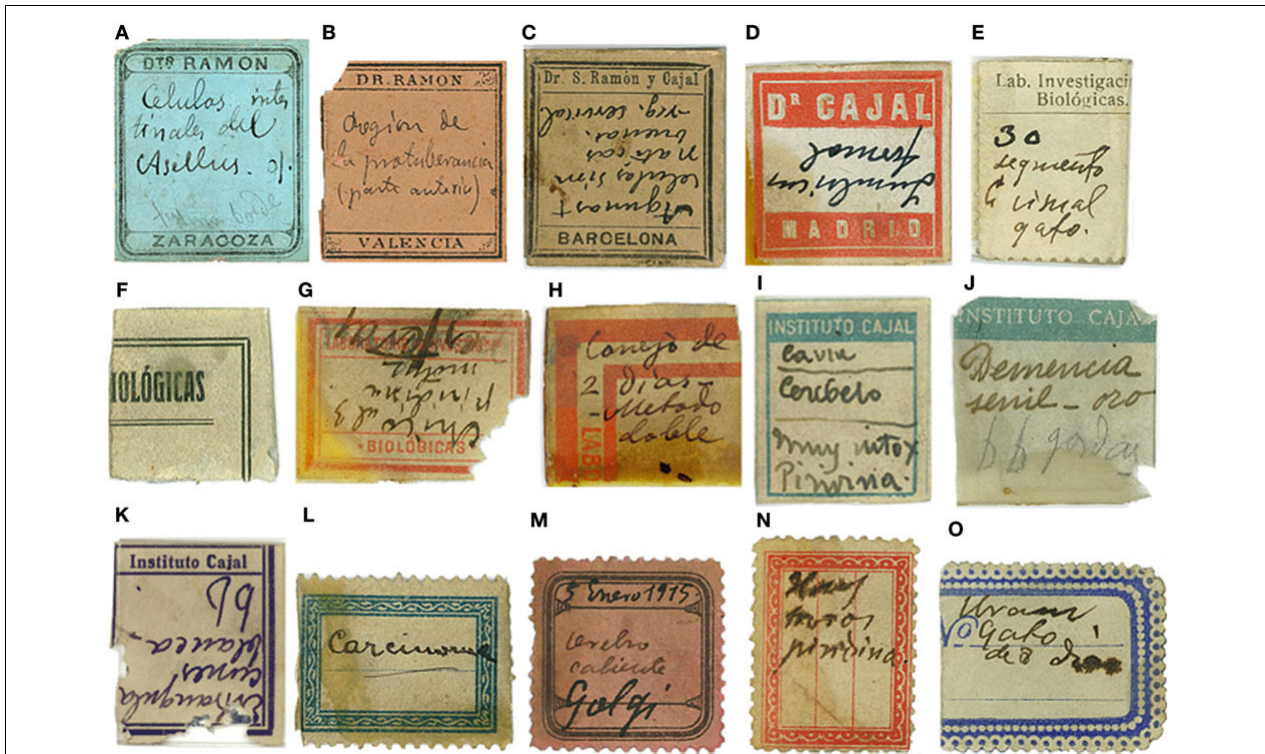
FIGURE 2 | Different labels Cajal attached to his histological preparations during his life. (A) 1877–1884, when Cajal was in Zaragoza; (B) , 1884–1897, when Cajal was in Valencia; (C) between 1887–1892 when he was in Barcelona; (D–H) from 1892 to 1920, Madrid; (I–K) approximately belong to the period after 1920; (L) from 1887, when he started to study neoplasias; (M–O) labels found in many histological slides probably from when he moved to Madrid until the end of his